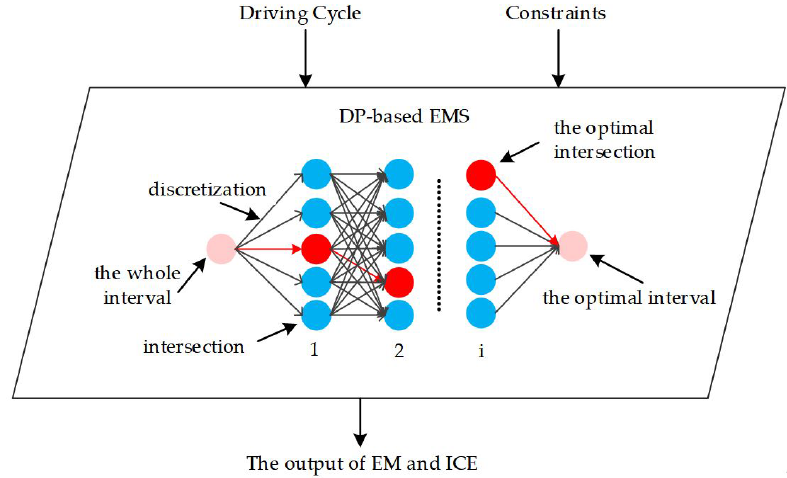
Figure 4. The principle of a DP-based